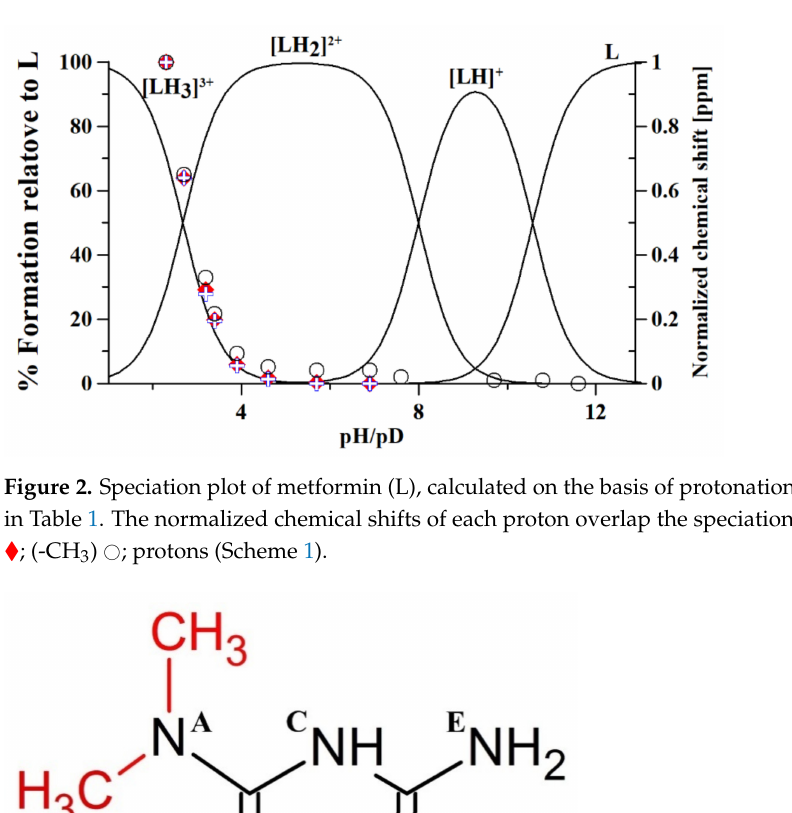
Figure 1. 1 H-NMR spectra of metformin in different pD conditions. ( A ) 6.7–8.2 ppm range; ( B ) 2.9–3.0 ppm range. Proton chemical shifts estimation is presented in Figure S3.